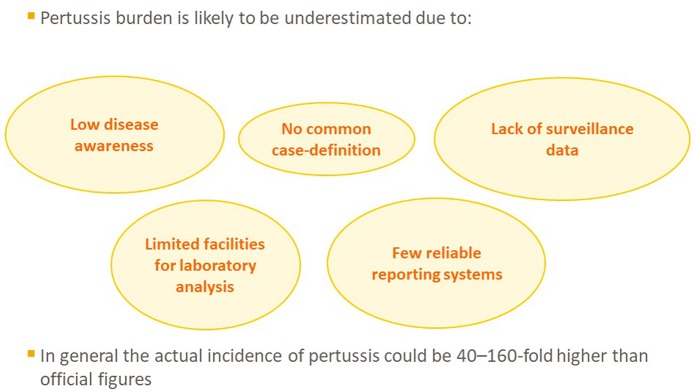
Reasons for underestimation of pertussis incidence and mortality.